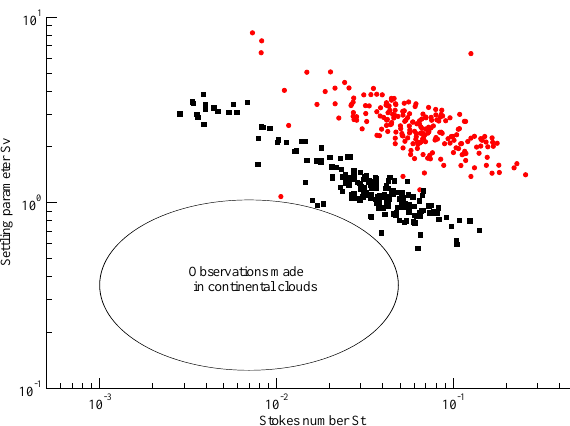
Fig. 14. Stokes and settling parameter space for 22 and 24 April. For comparison, the black ellipse marks the parameter space occupied by observations made in continental clouds (Siebert et al., 2010a).